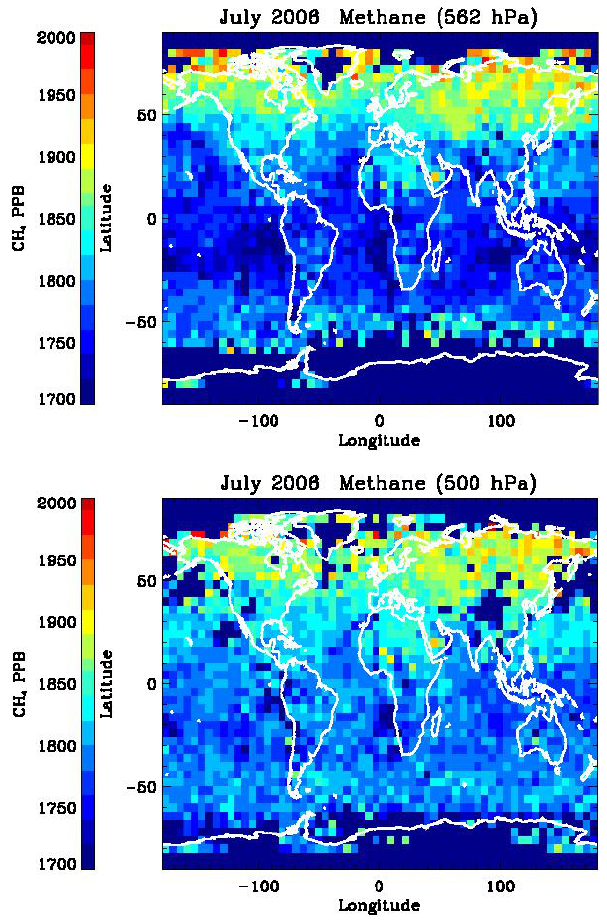
Fig. 11. (Top) TES estimated methane at 562hPa. (Bottom) TES estimated methane at approximately 500hPa using an “informa- tion” averaging